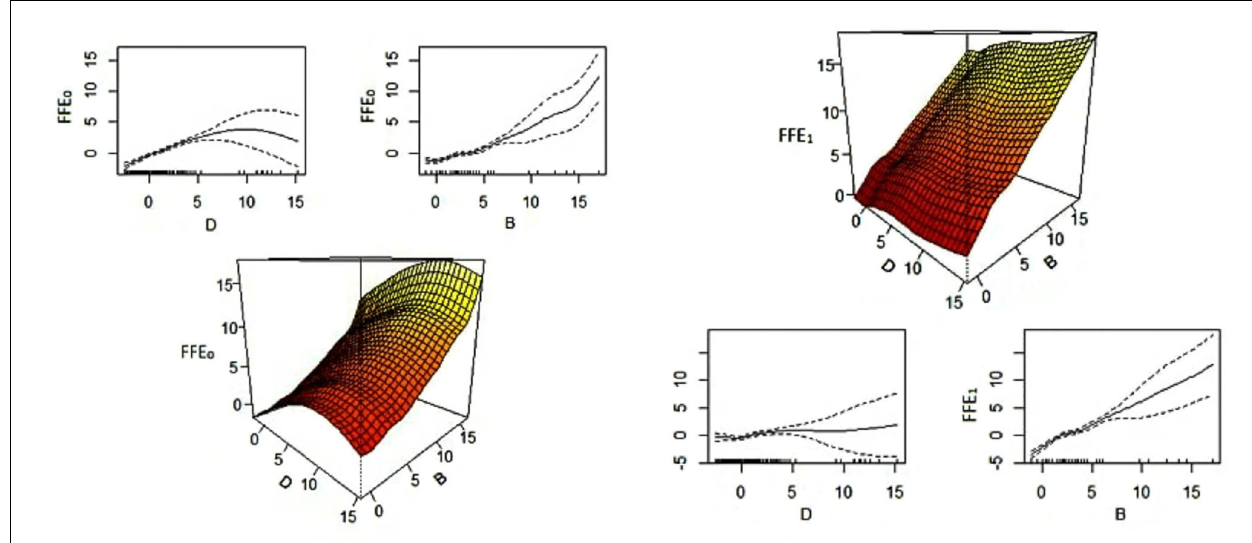
FIGURE 4 | GAM smoothing fits with one standard error confidence interval and three-dimensional plot for imputation of FFE 0 (left) and FFE 1 (right).